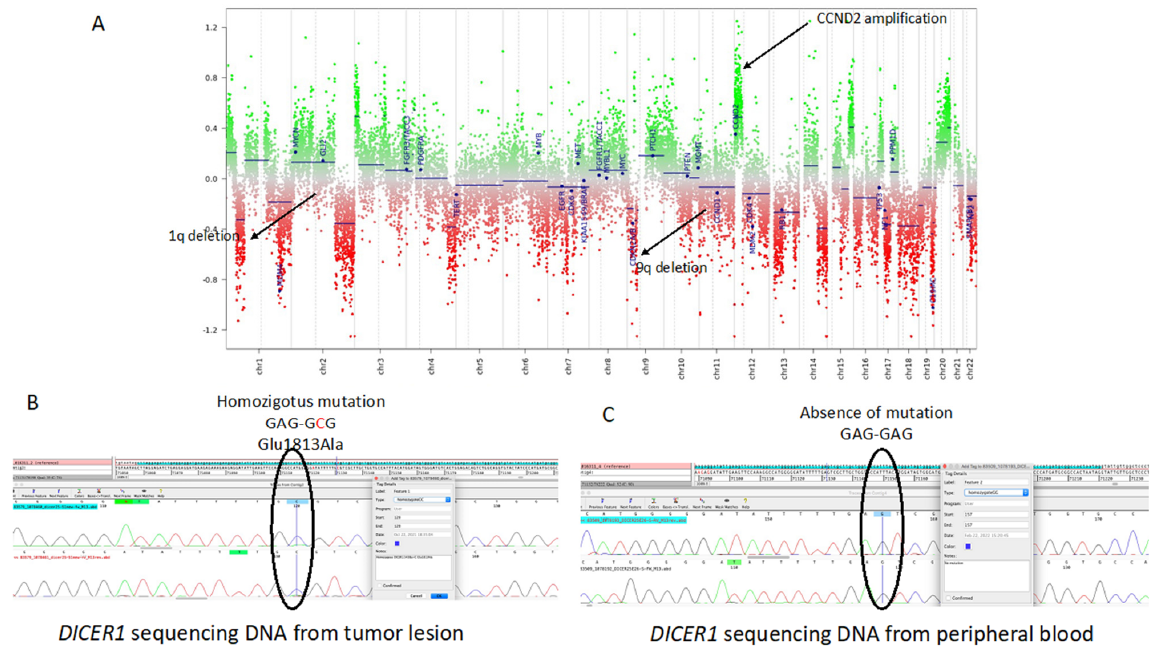
Figure 4. ( A ) Copy number variation (CNV) plot based on DNA methylation array data. For the calculation of CNV values, a ratio between the methylated and unmethylated data was compared with a healthy reference with a flat genome. Chromosomes are shown on the x-axis, and the log2 copy number ratio is shown on the y-axis; for every chromosome, the p-arm ( left ) and q-arm ( right ) are separated by a dotted line. Gains or amplification, in green, were calculated as positive values placed above the baseline, and deletions or losses, in red, as negative values under the baseline; in this manner, 1p and 9q deletions were clearly visible, as well as CCND2 amplification on chromo- some 12. ( B ) Sanger sequencing of the DNA of the second lesion. The electropherogram shows the homozygous mutation Glu1813Ala in exon 25 of the DICER1 gene. ( C ) Sanger sequencing of periph- eral blood DNA. The electropherogram shows wild-type DICER1 . 2.4. Molecular Investigation: DICER1 and p53 Gene Sequencing To verify the presence of the DICER1 mutations predicted by methylome analysis, we performed DNA sequencing of the DICER1 gene utilizing DNA extracted from the tumor removed in December 2020. As shown in Figure 4B, we found a homozygous, hotspot mutation in DICER1 exon 25, resulting in the aminoacidic substitution Glu1813Ala. The same mutation was reported in other cases [13]. Thus, DICER1 DNA sequencing confirmed the diagnosis predicted by the methylome profile. The same Glu1813Ala mutation was also found at 50% in the primary intracranial lesion removed